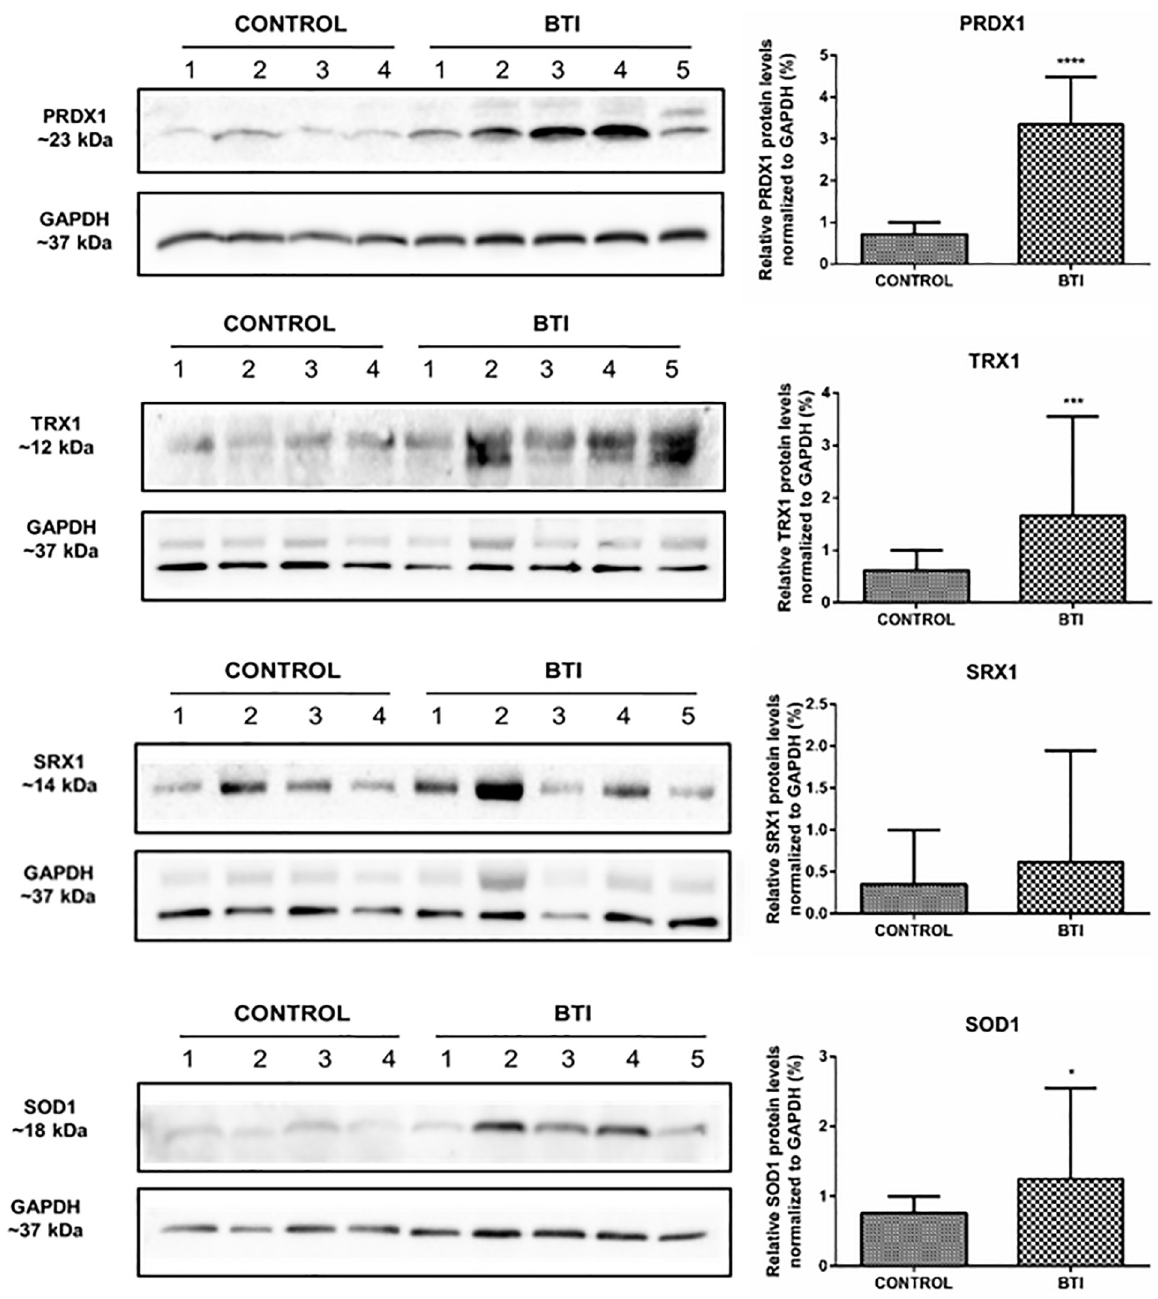
Fig 3. Representative western blot of Prdx1, Trx1, Srx1 and Sod1 expression in the erythrocyte cell lysate of beta-thalassemia intermedia patients compared to healthy individuals. Protein levels were measured in mature cell erythrocyte lysate from 10 patients and 8 healthy subjects. Samples were separated in a 12% (w/v) reducing SDS–PAGE using 50 μ g of total protein from each sample. The intensity of the bands was measured using GAPDH as the endogenous reference. Quantitative analyzes were performed by densitometry using ImageJ Software [35]. The results are presented as mean and standard error ( ± SEM), and are representative of two independent experiments ( � p < 0.05), ( ��� p <